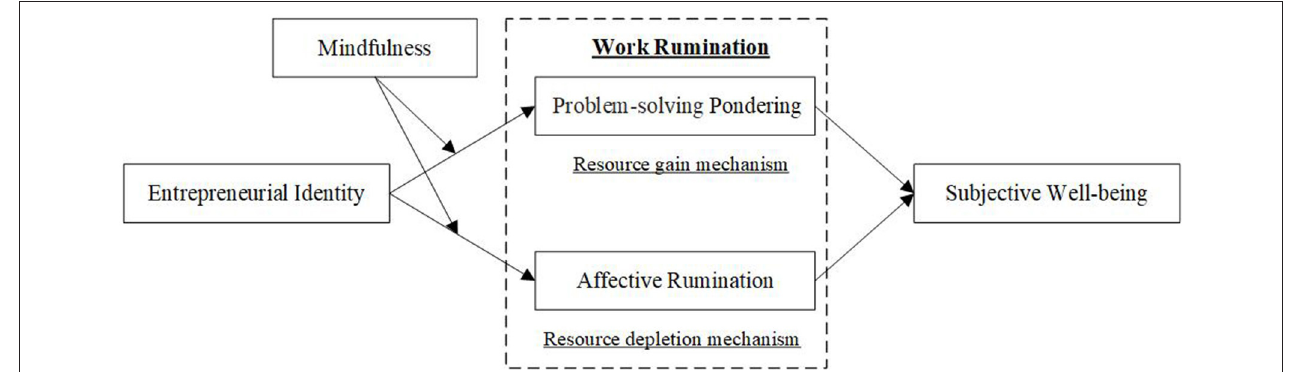
FIGURE 1 | Theoretical